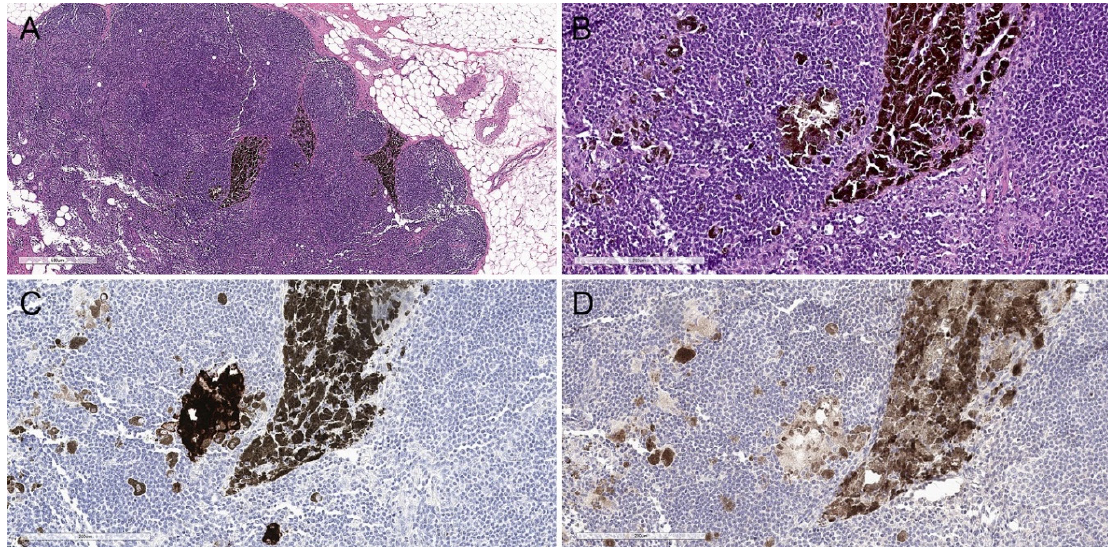
Figure 6. Sentinel lymph node deposits from a patient with an atypical deep penetrating nevus. ( A ) Hematoxylin and eosin, 40 × . ( B ) Hematoxylin and eosin, 200 × . Multiple clusters of coarsely and densely pigmented epithelioid cells are noted within the lymph node parenchyma and subcapsular space. ( C , D ) Lesional cells are highlighted on immunohistochemical studies with ( C ) a melanocytic cocktail (anti-MART1, HMB45, and anti-tyrosinase, 200 × ) and ( D ) SOX10 (SOX10, 200 ×